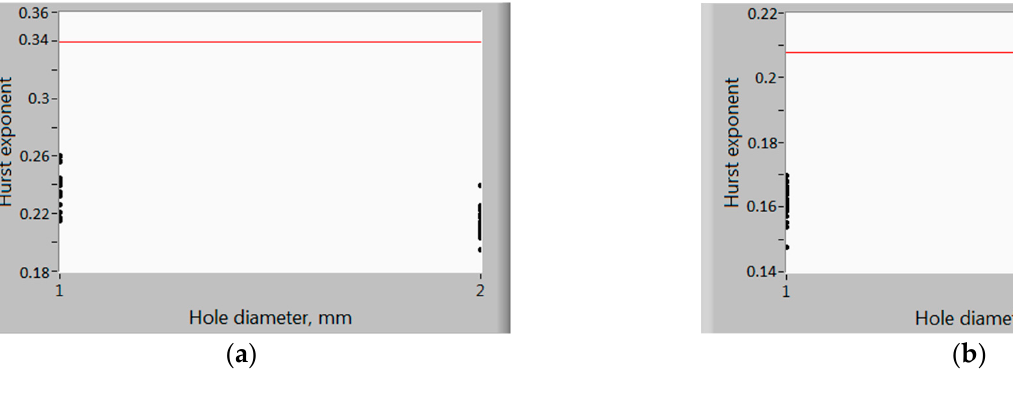
Figure 9. Values of the Hurst exponent at a pump discharge pressure of 3 bar: ( a ) for X-axis signals, ( b ) for Y-axis signals.